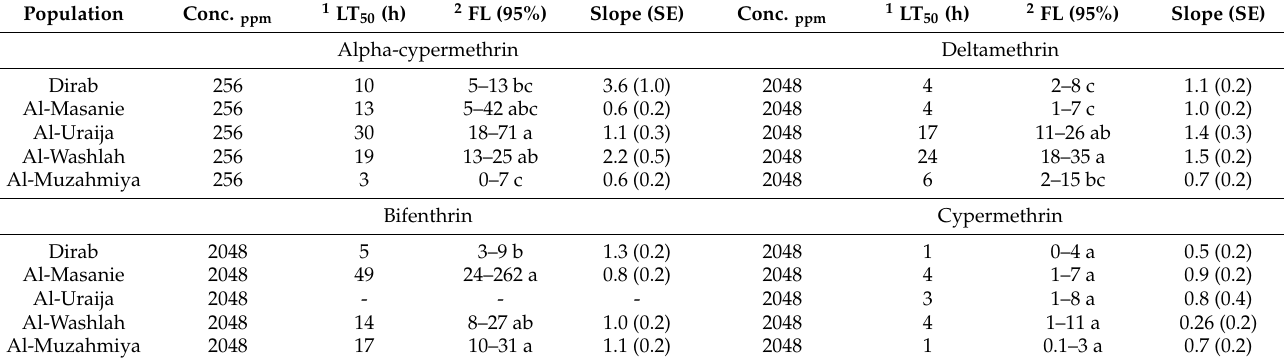
Table 6. Median lethal time (LT 50 ) of pyrethroids and organophosphates in female house flies.